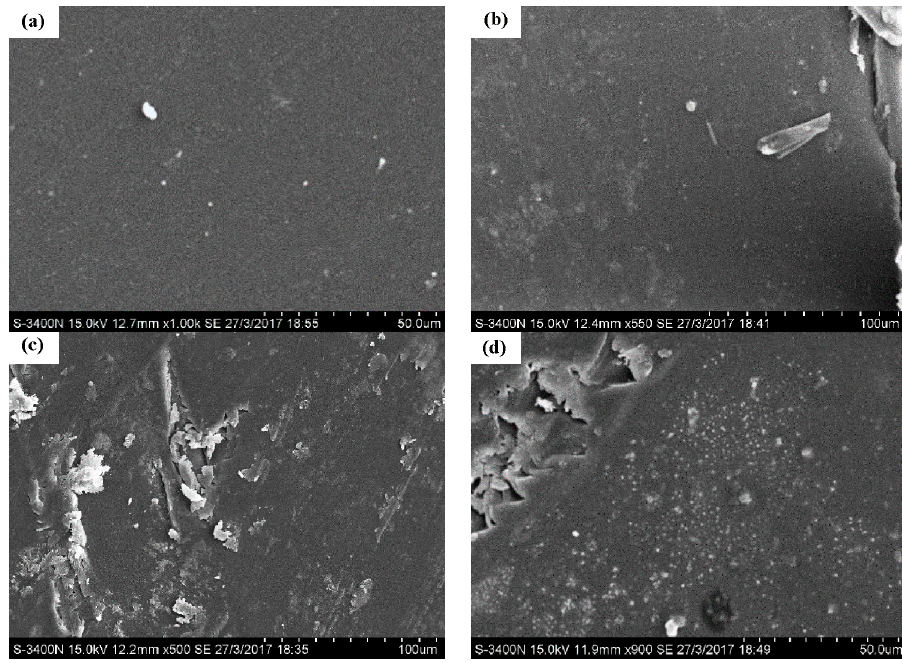
Figure 10. The morphologies of the BFRP sheets, ( a ) control; ( b ) 180 cycles; ( c ) 270 cycles; ( d ) 360 cycles.